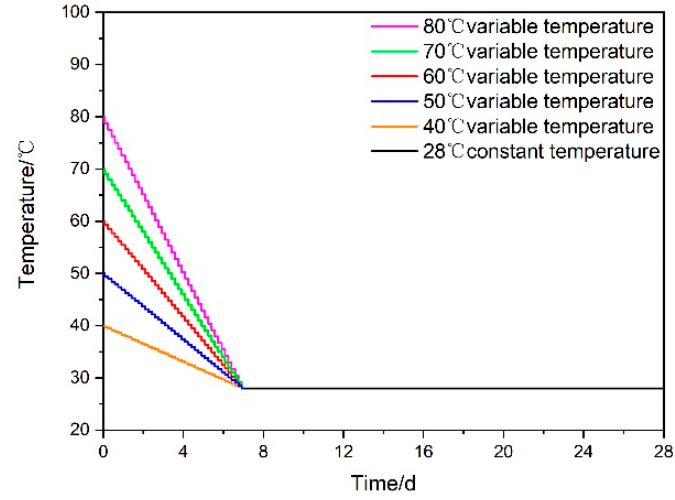
Figure 16. Relationship between curing temperature and curing time of new curing mode.